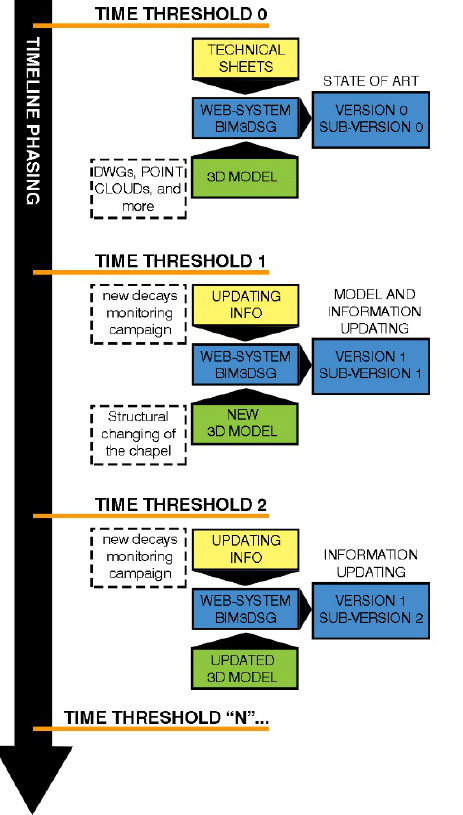
Figure 3. BIM3DSG time phasing: Threshold 0 is the existing condition of the chapel, with 3D model and information. In the Threshold 1, there is an updating both of the info and model, so they become version 1 and subversion 1, and so on.